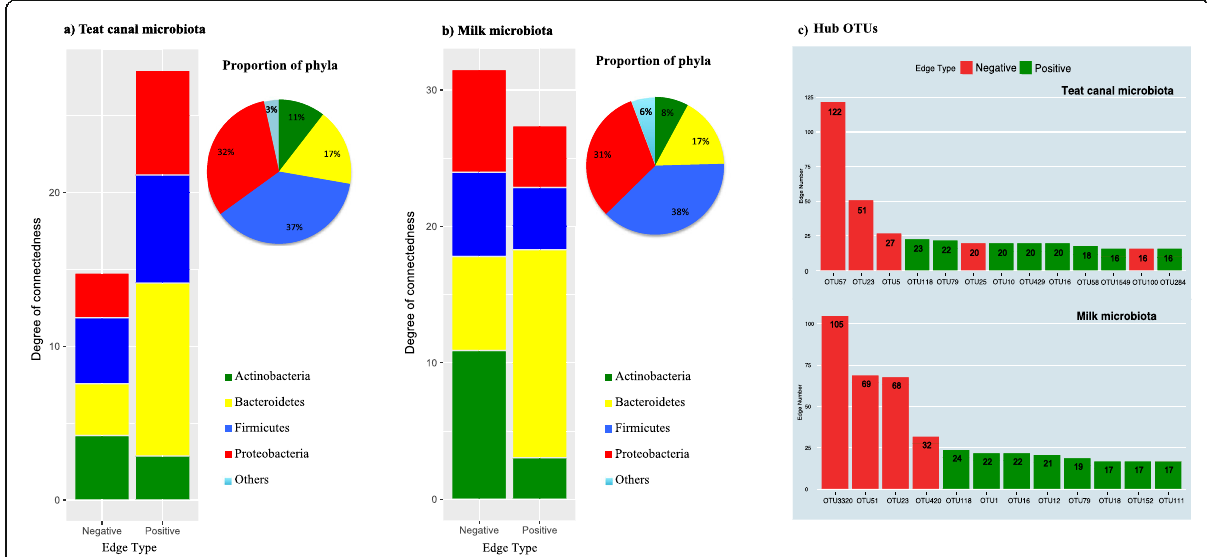
Fig. 3 Summary of microbial interaction networks. The degree of connectedness of bacterial phyla has been shown within a ) teat canal and b ) milk microbiota. The bar charts show the total number of positive (co-occurrence) or negative (mutual exclusion) interactions observed within the OTUs belonging to major bacterial phyla divided by the average relative abundance of each phylum. The pie charts show the average proportion of bacterial phyla within each niche of the mammary gland. The color codes relate to different bacterial phyla c ) shows the total number of positive or negative edges (interactions) observed for hub OTUs (OTUs with a minimum number of 16 connections with other members of the microbiota). Color codes denote the type of integrations as revealed by CoNet